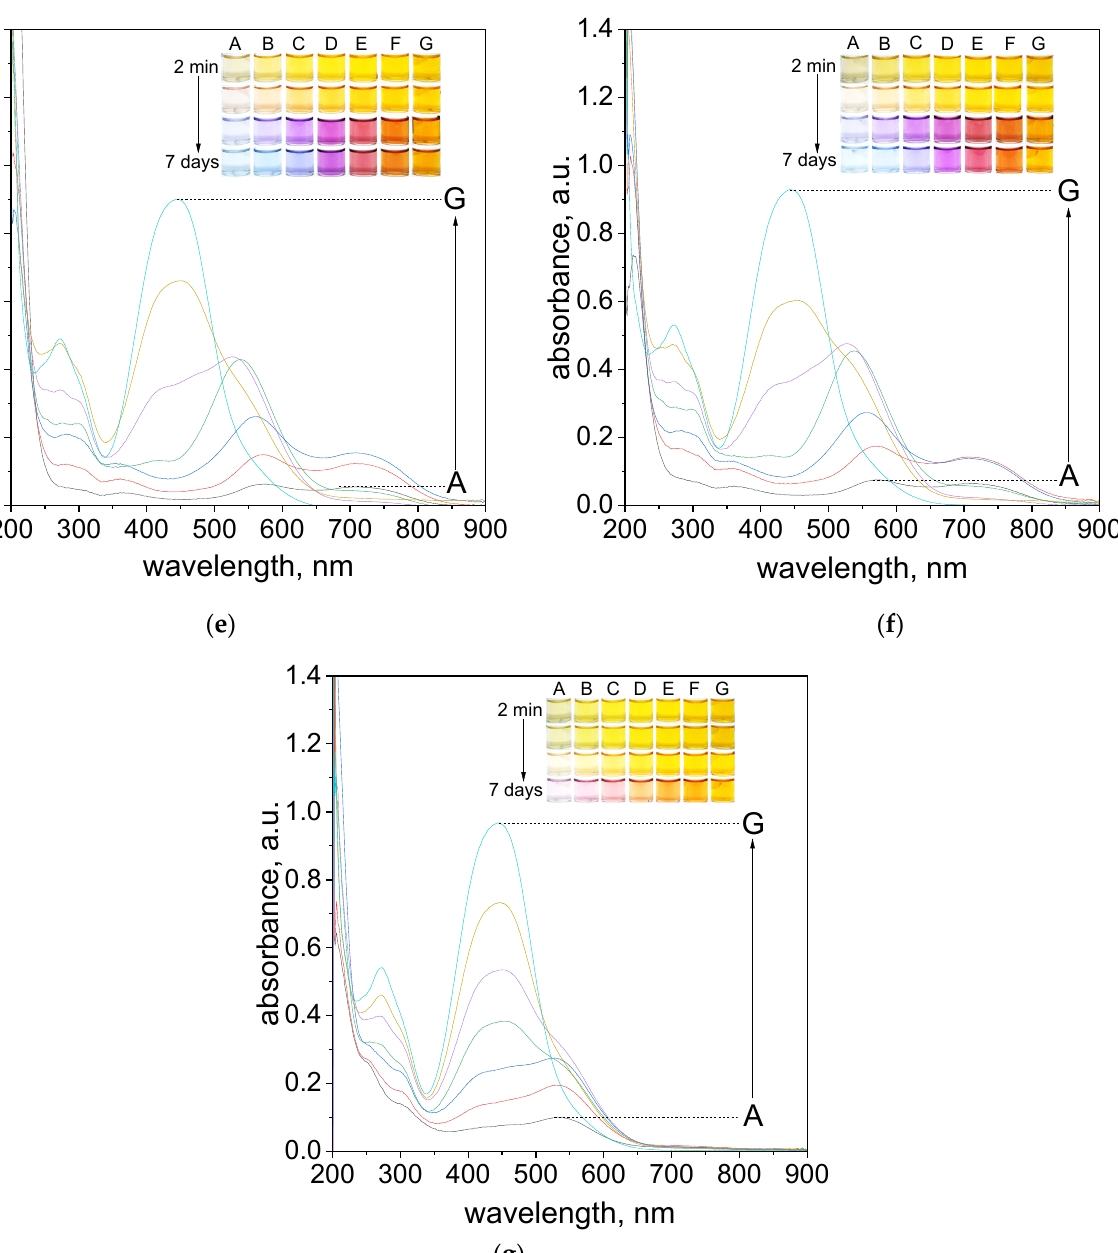
Figure 2. The UV–Vis spectra of solution containing the mixture of tropaeolin OO and Pd(II) at different volume ratio (mL/mL) of Pd(II) to TR (A—0.5:3.5; B—1.0:3.0; C—1.5:2.5; D—2.0:2.0; E—2.5:1.5; F–3.0:1.0; G–3.5:0.5) in H 2 O registered after one hour ( a ) and after 7 days ( b ) and registered after 7 days in B-R buffer, pH: 2.09 ( c ), 2.87 ( d ), 4.10 ( e ), 5.02 ( f ), 6.09 ( g ). Conditions: C 0,TR = 5 × 10 − 5 mol/dm 3 , C 0,Pd(II) = 5 × 10 − 5 mol/dm 3 (the value of concentration before reagents mixing), T = 20 °C, path length 1 cm.